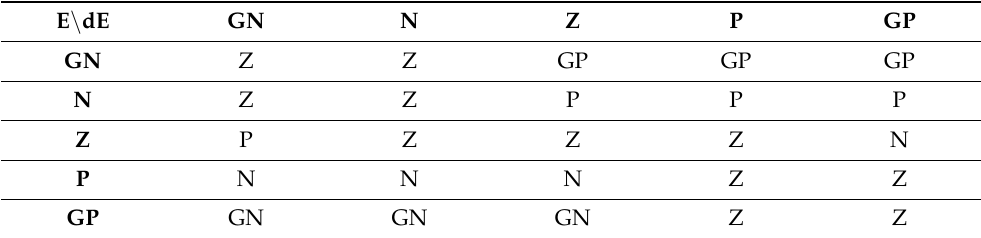
Table 3. Fuzzy controller inference rules.